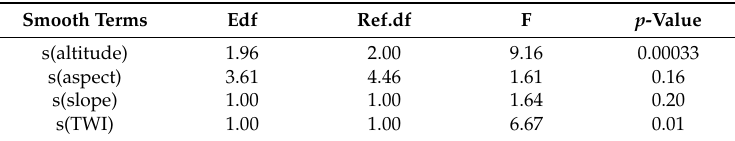
Table 3. Approximate significance of smooth